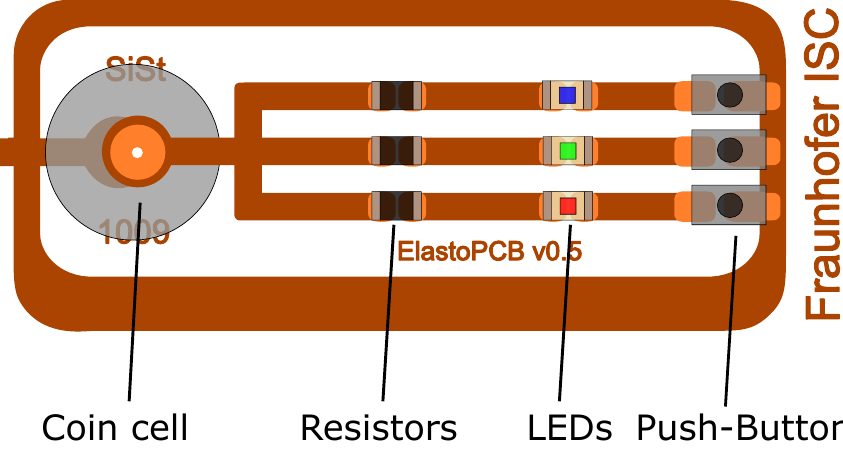
Figure 2. Schematic diagram of the structure and assembly of the stretchable circuit